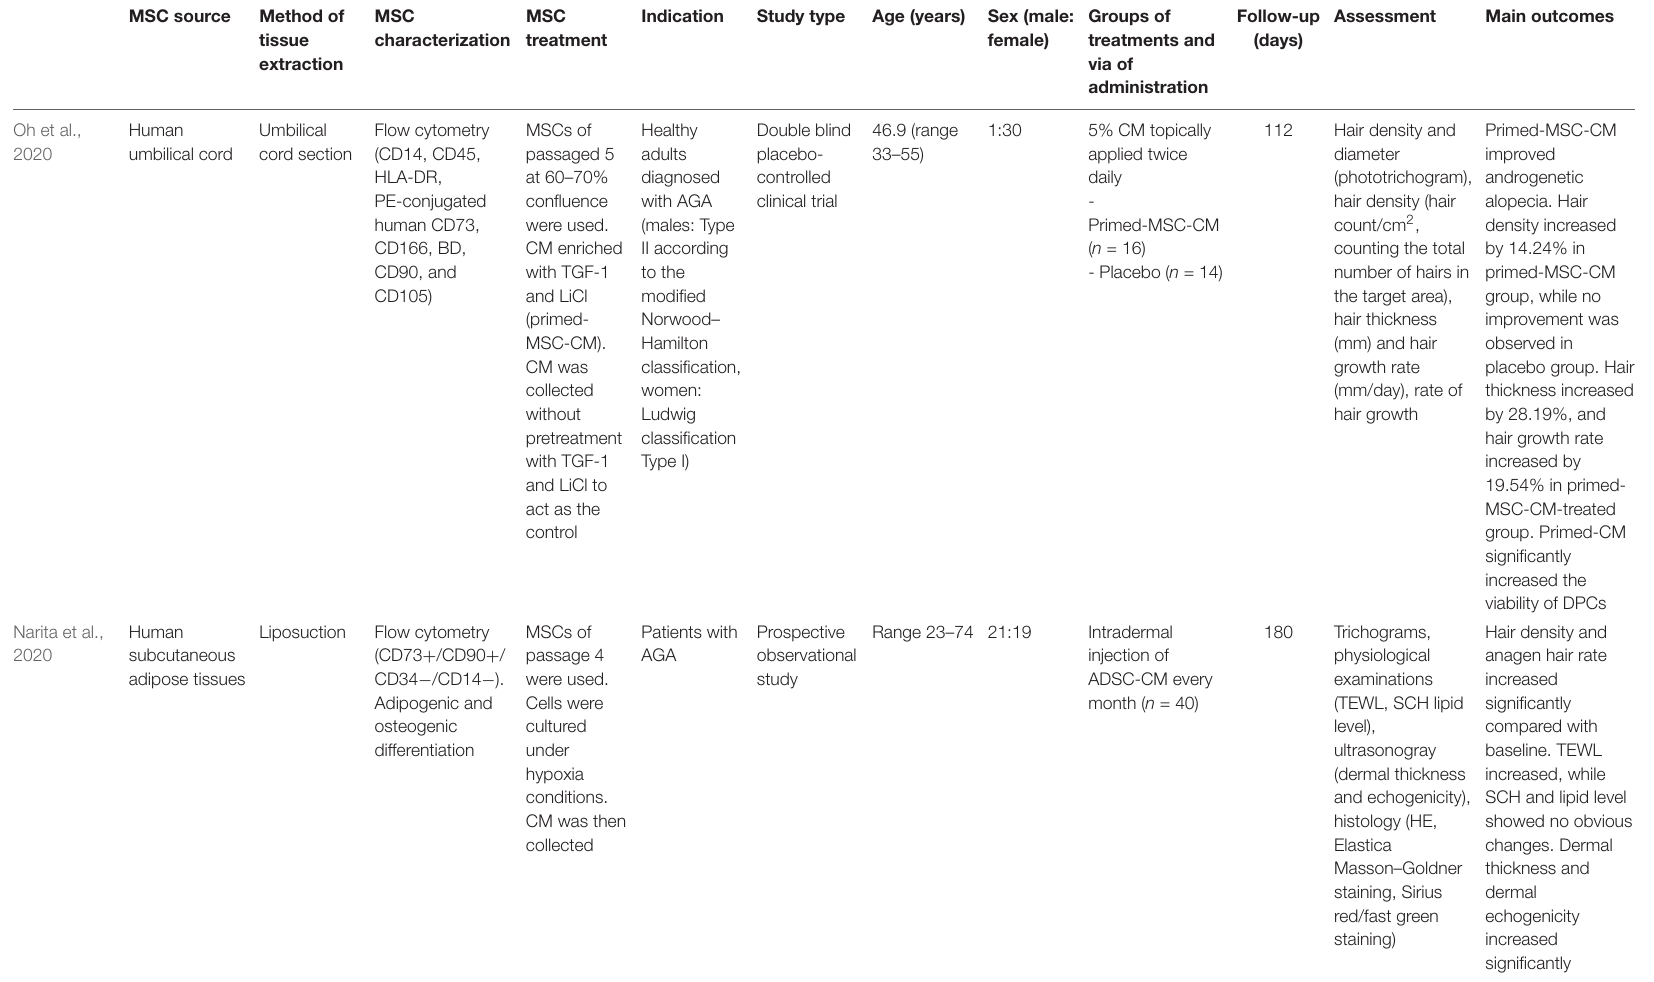
TABLE 8 | Studies regarding mesenchymal stromal cell-conditioned medium for hair restoration in